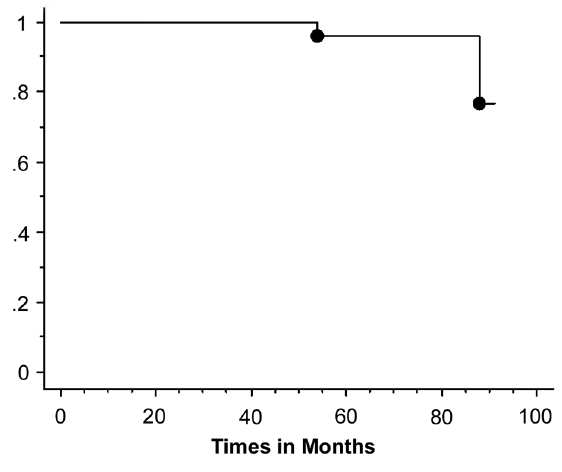
Figure 2 – Cumulative survival rate in patients undergoing neph- ron-sparing surgery by simple